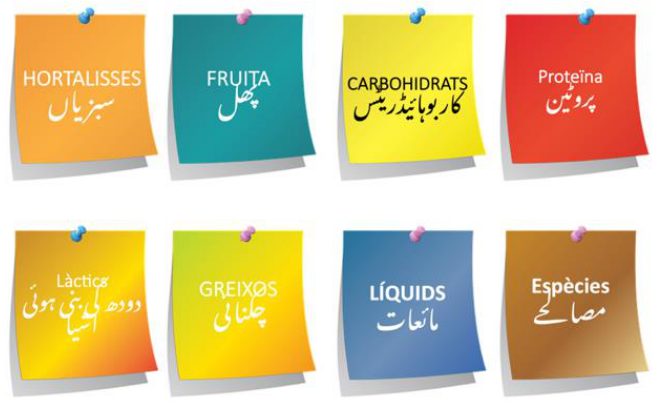
Figure 6. Checklist of food groups for daily/weekly food purchasing.